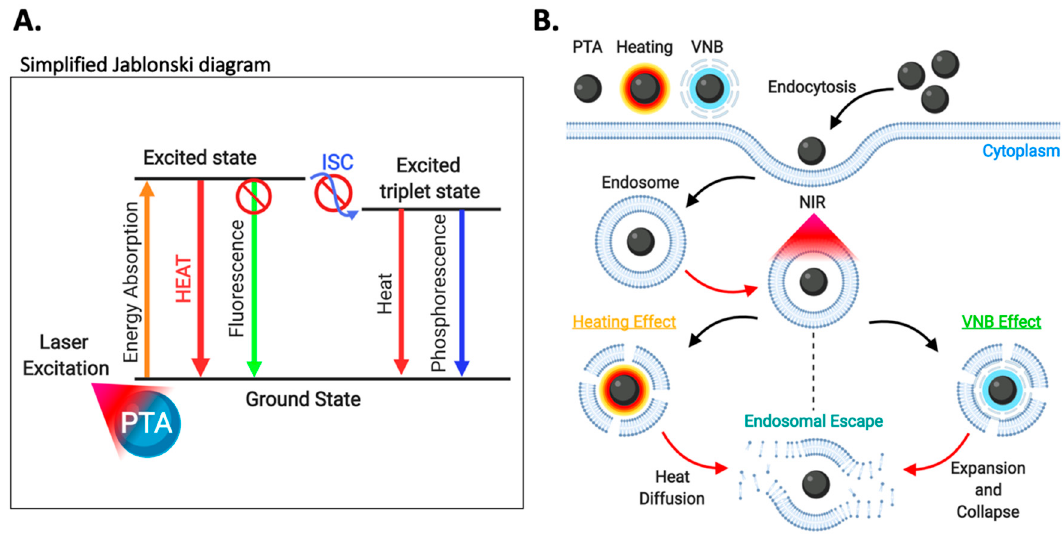
Figure 10. ( A ) Simplified Jablonski diagram describing the different energy transfer mechanisms involved in PTT. PTA: photothermal transduction agent, ICS: intersystem crossing. ( B ) Schematic illustration of the PTT process. Photothermal transduction agents (PTAs) are taken up by endocytosis and trapped into the endosomes. After NIR irradiation, PTAs absorb the light energy and transform it into heat, which could lead to endosomal escape by two major mechanisms. In the first one, also known as the heating effect leads to the destabilization of endosomal membranes by a localized increase in temperature. In the second one, the released heat is high enough to generate a vapor layer surrounding the PTAs such that it expands as a vapor nanobubble (VNB) that eventually collapses to induce endocytic membrane disruption. (Created with BioRender.com).